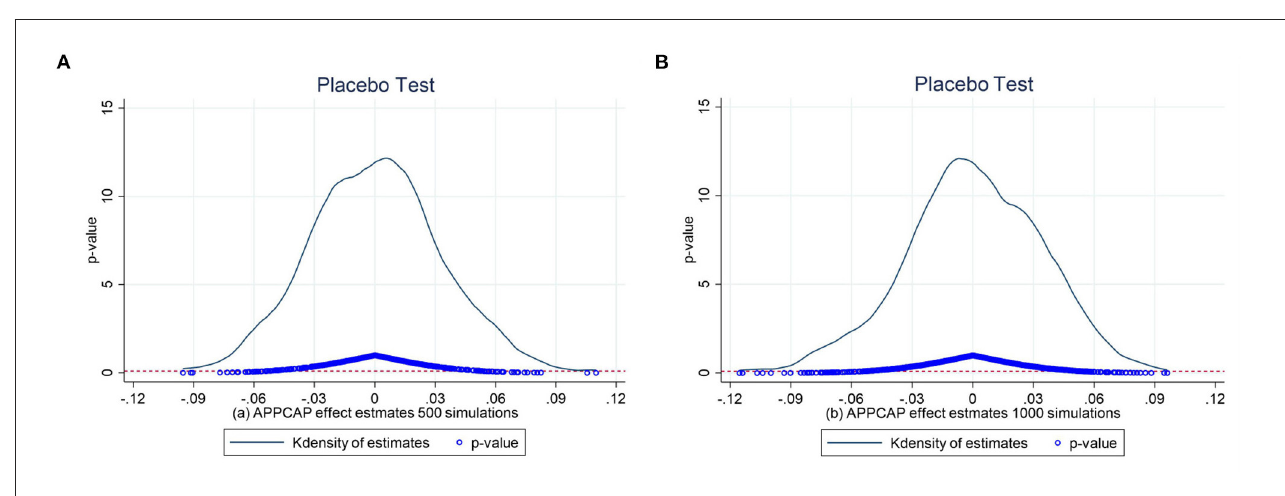
FIGURE4 Placebo test. (A) 500 times. (B) 1,000